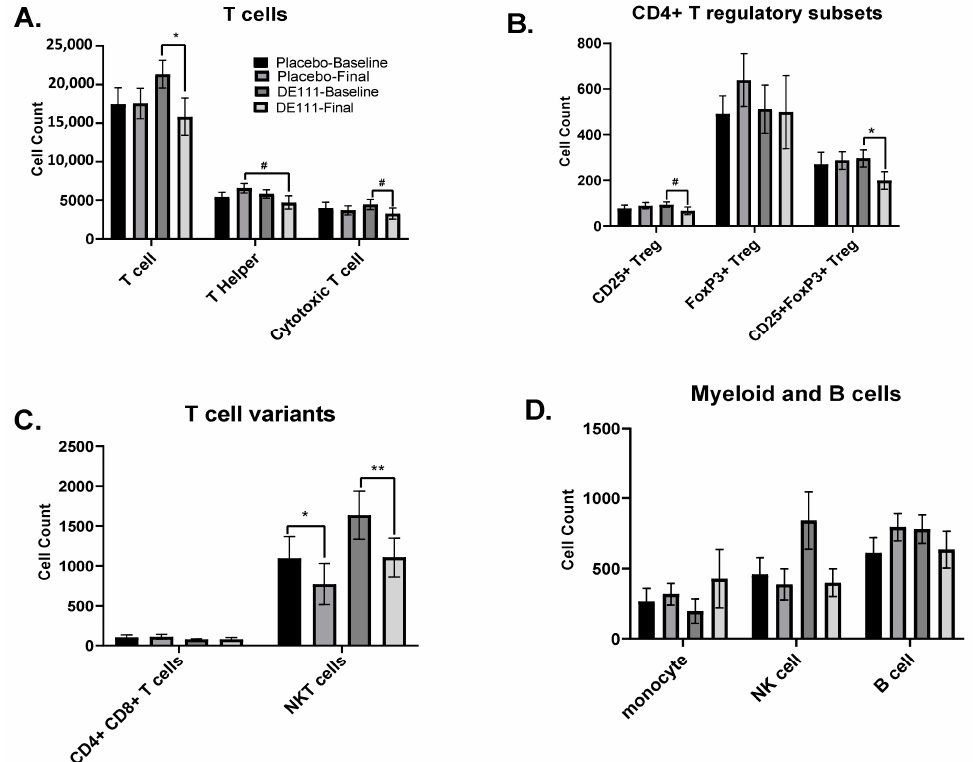
Figure 5. Basal immune status at baseline and post-intervention in Placebo and DE111 groups: Total CD3+ T cell populations ( A ), CD4+ T regulatory subpopulations ( B ), T cell variants ( C ), and myeloid and B cells ( D ). Error bars represent ± SEM. * denotes p < 0.05, **denotes p < 0.01, and # denotes a p -value between 0.05–0.08.